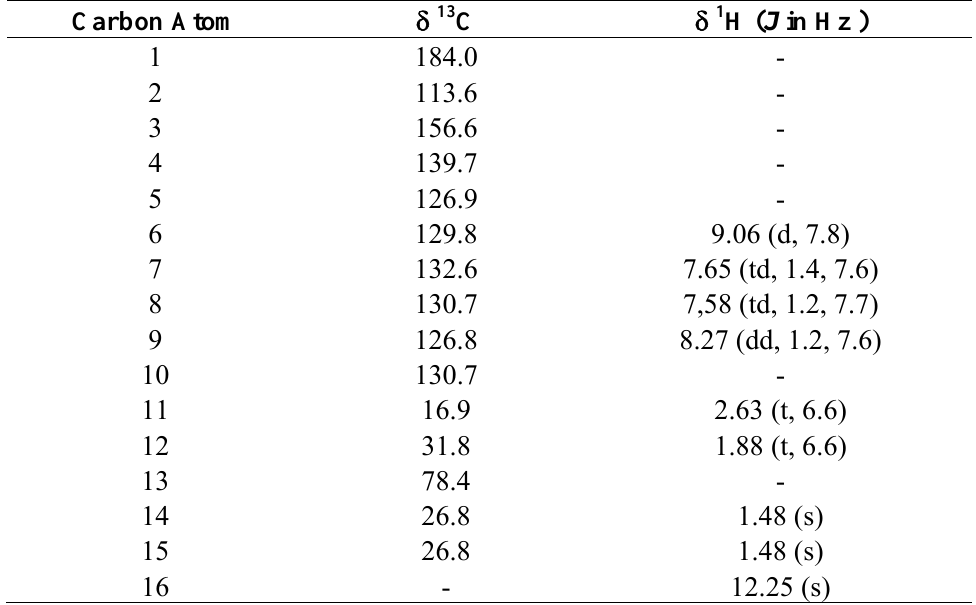
Table 1. 1 H- and 13 C-NMR data for 1